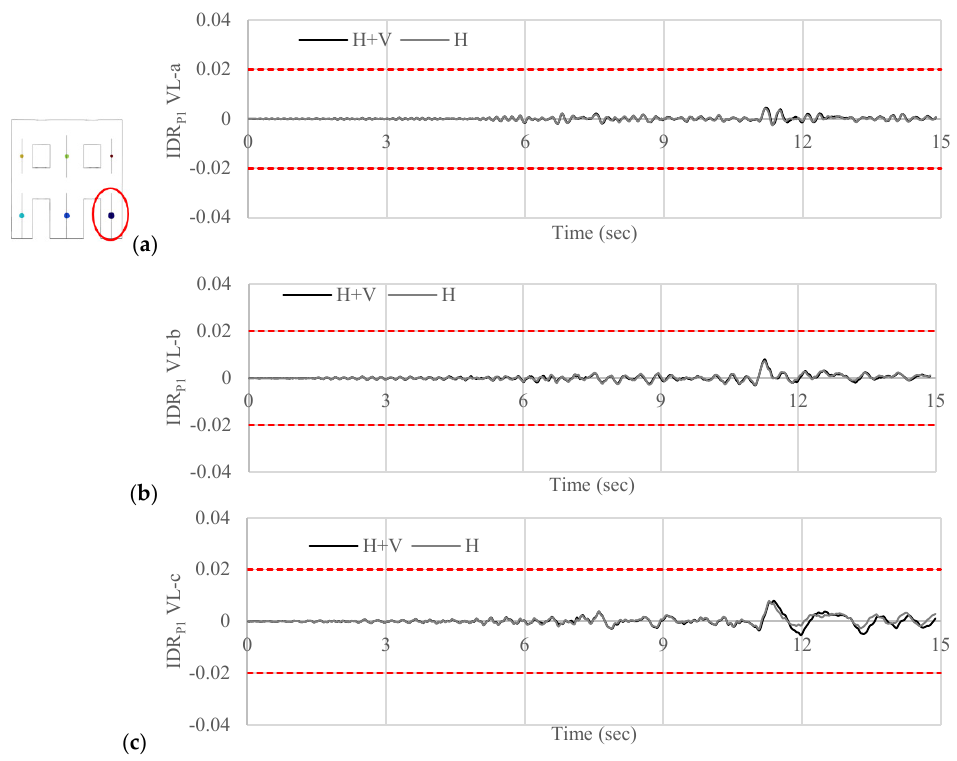
Figure 14. IDRs obtained subjecting the structure with VL-a ( a ), VL-b ( b ), and VL-c ( c ) to earthquake #3. The red lines indicate the IDR limit of 2%.